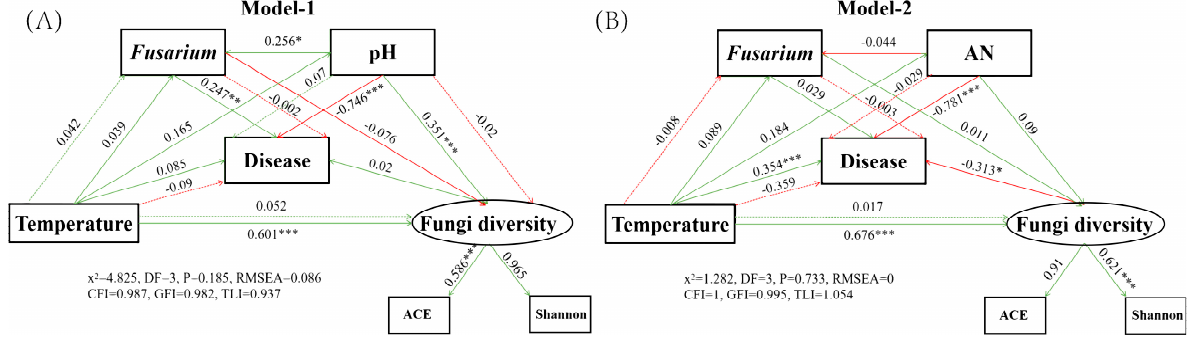
Figure 6. Structural equation modeling (SEM) analysis showed the contributions of Fusarium, temperature (soil temperature), soil and fungi diversity to the sugarcane disease. The disease was pokkah boeng disease of sugarcane. Soil was represented by mainly compositions including pH and AN (Available Nitrogen), and Model − 1 ( A ) and Model − 2 ( B ) were constructed respectively. Fungi diversity included ACE and Shannon index. The number above the arrow indicates the normalized path coe ffi cient. p − value: * < 0.05; ** < 0.01; *** < 0.001.